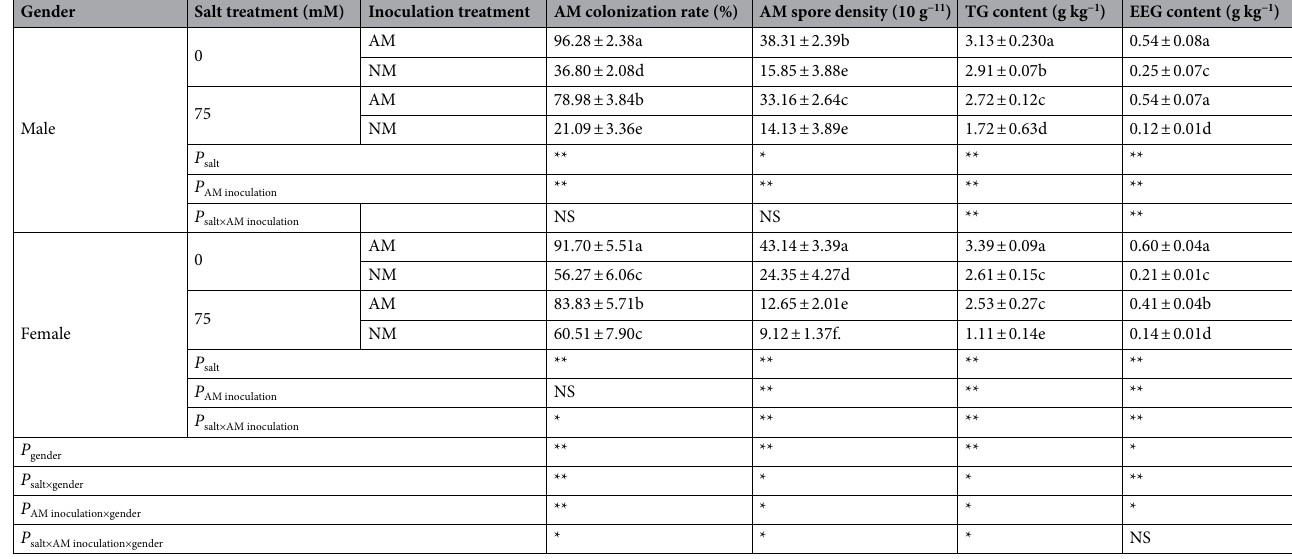
Table 2. Effects of exogenous AM inoculation on AM colonization, AM spore density and glomain contents in the rhizosphere of P . cathayana males and females under different salt conditions. AM, exogenous AM inoculation; NM, non-exogenous AM inoculation; 0 mM, without salt stress; 75 mM, under salt stress. **: significant effect at P ≤ 0.01; *: significant effect at 0.01 ≤ P ≤ 0.05; NS: no significant effect P > 0.05. Different lowercase letters indicate significant difference ( P ≤ 0.05), the data are means ± SD (n =